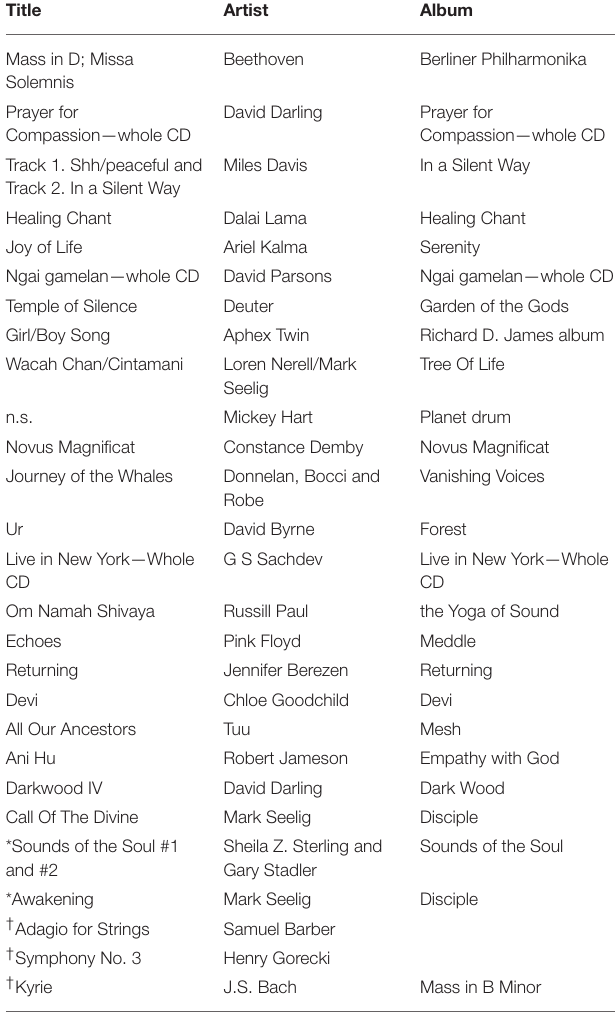
TABLE 2 | Stimuli recommended for peak